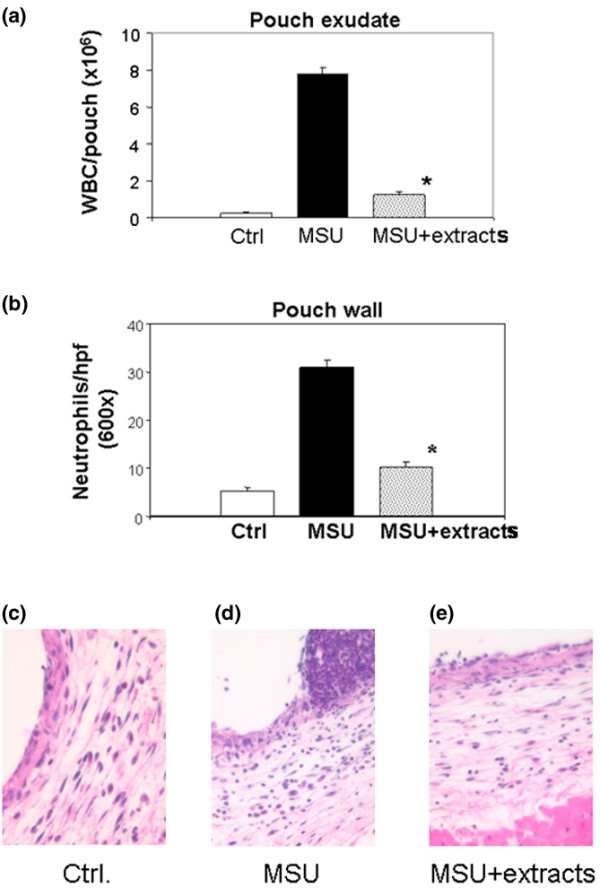
Treatment with root extracts reduces leukocyte recruitment into the pouch wall and their accumulation in the pouch exudate. The experimental groups in these and subsequent experiments were as follows: (1) Ctrl (gavage feeding with water and intrapouch injection of PBS); (2) MSU (gavage feeding with water and intrapouch injection of MSU crystals in PBS); and (3) MSU + extracts (gavage feeding with extracts and intrapouch injection of MSU crystals in PBS). (a) Leukocyte count in the pouch exudate, expressed as leukocytes per pouch. The numerical values (all × 106 ± standard error of the mean) were as follows: Ctrl, 0.26 ± 0.03; MSU, 7.80 ± 0.33; and MSU + extracts, 1.24 ± 0.18. The percentage changes detected in this and all other experiments are summarized in Table 3. (b) Polymorphonuclear cell density in the pouch wall (cells per × 600 field ± SEM): Ctrl, 5.30 ± 0.78; MSU, 31.02 ± 1.55; MSU + extracts, 10.08 ± 1.12. (c–e) H&E stains of representative sections from pouch walls obtained from control (c), MSU (d) and extract treatment (e) groups. Higher magnification revealed that the control wall contained mostly fibroblasts and mononuclear cells. Abundant polymorphonuclear cells were seen in the MSU-stimulated pouch wall (d), the number of which was decreased by treatment with the root extracts (e). Ctrl, control; H&E, hematoxylin and eosin; Hpf, high-power field (× 600); MSU, monosodium urate; PBS, phosphate-buffered saline; WBC, white blood cell count.